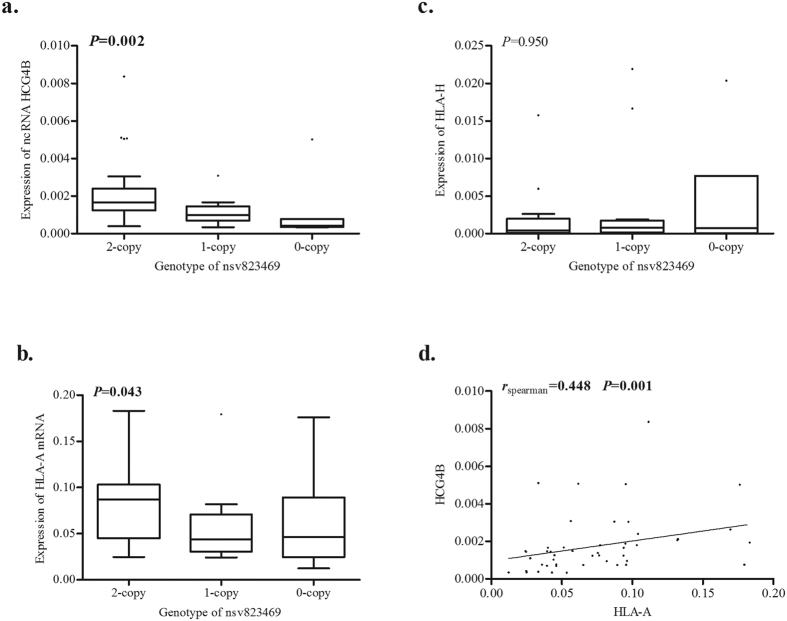
The expression of nsv823469 covering gene and lncRNA.(a) Effect of the CNV copy number on HCG4B; (b) Effect of the CNV copy number on HLA-H; (c) Effect of the CNV copy number on HLA-A; Bars = SD. P value was inferred with the Kruskal-Wallis test. As shown, significant deviation was observed for HCG4B and HLA-A but not HLA-H between different copy number tissues; (d) Correlation between the expression of HCG4B and HLA-A. A significant correlation between HCG4B and HLA-A was observed. The spearman rank correlation test was used.